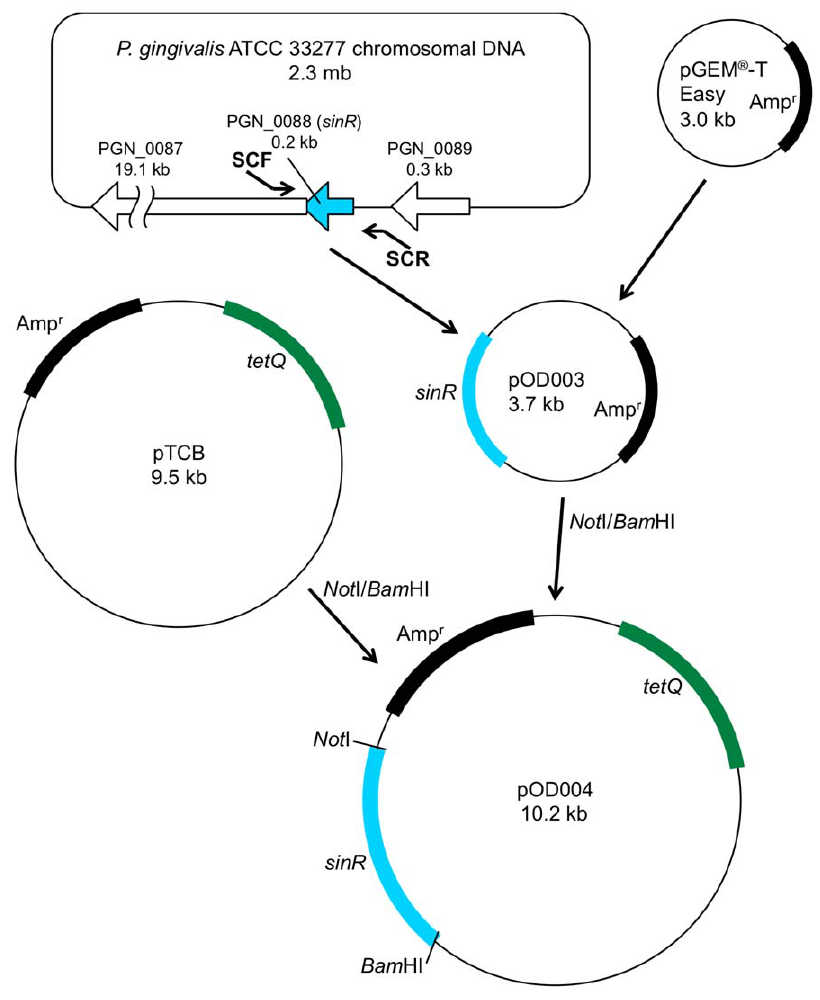
Figure 6. Scheme of construction of the sinR + -complementing strain. The 0.7-kb DNA fragment (aqua) containing the sinR gene region was PCR-amplified from ATCC 33277 chromosomal DNA with SCF and SCR primers. The amplified DNA fragment was cloned into the pGEM H -T Easy vector, resulting in pOD003. The sinR region DNA obtained by Not I and Bam HI digestion was inserted into Not I- Bam HI-digested pTCB [38] to yield pOD004 ( sinR +